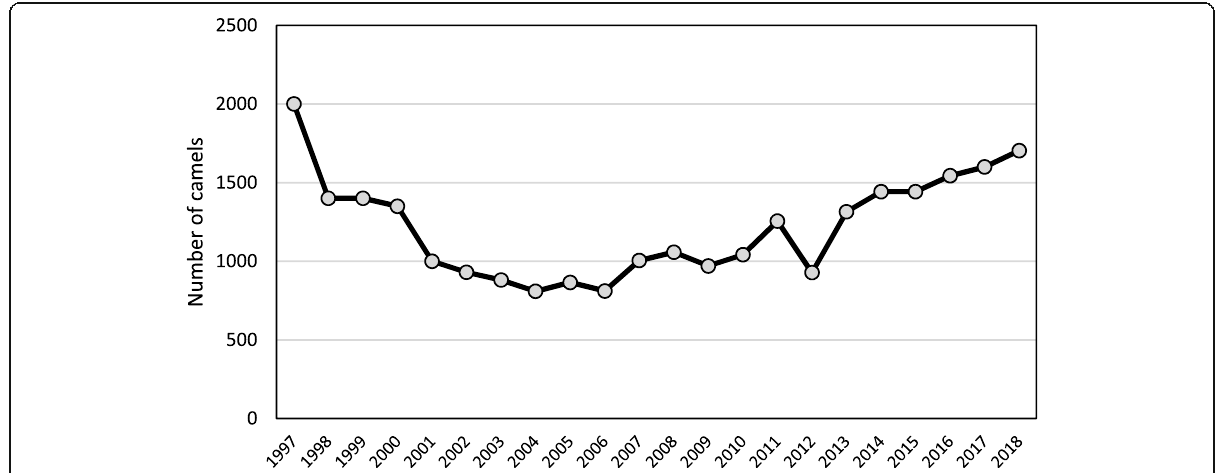
Fig. 7 Changes in Turkish camel population for the last 20 years (source: FAOstat)